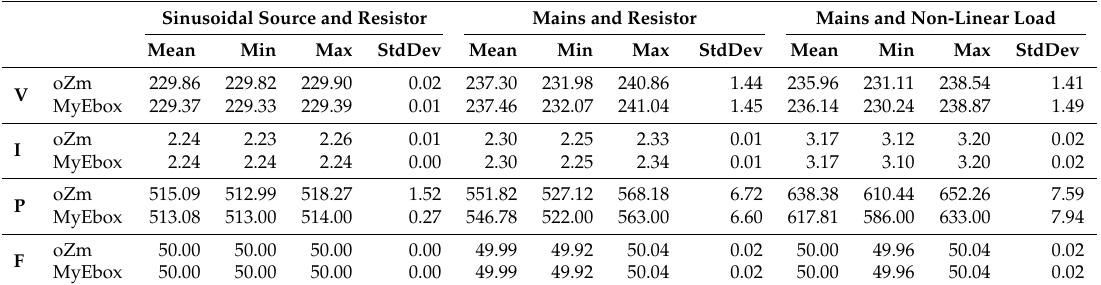
Table 3. Comparative test for oZm and MyEBOX under different